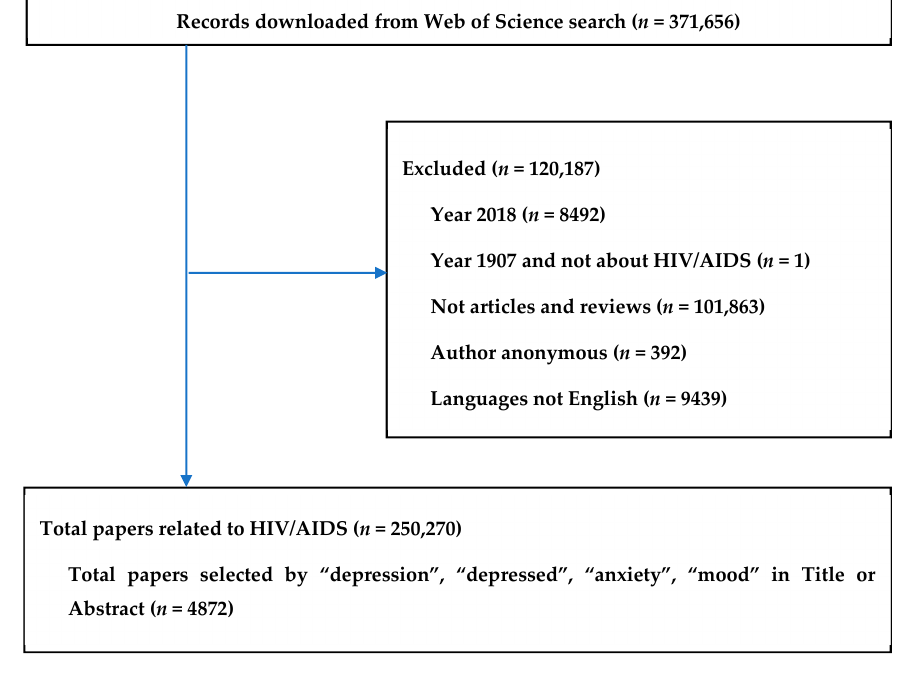
Figure 1. Selection of papers. Table 1. General characteristics of